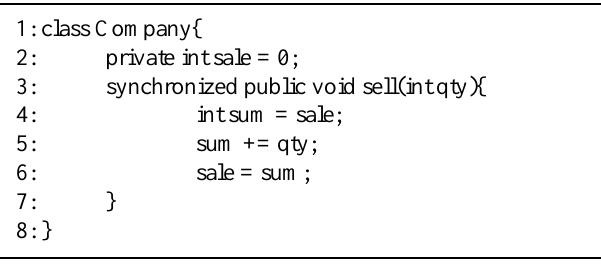
Figure 7. The sample code of synchronized